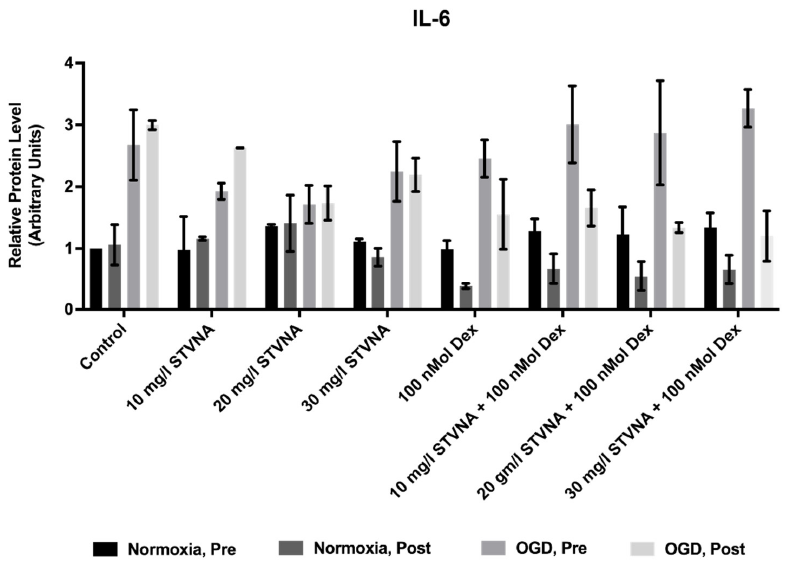
Figure 1. Secretion of pro-inflammatory cytokine IL-6. Multiplex ELISA reveals a trend towards reduced IL-6 expression upon administration of 20 mg/L STVNA, as well as STVNA in combination with 100 nMol dexamethasone post-OGD.